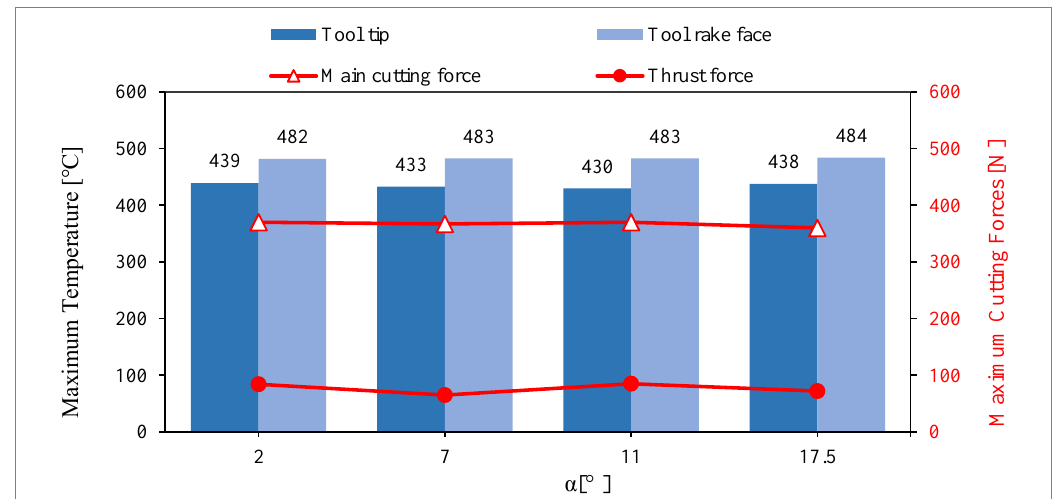
Figure 19. Maximum cutting temperatures and forces at various clearance angles.